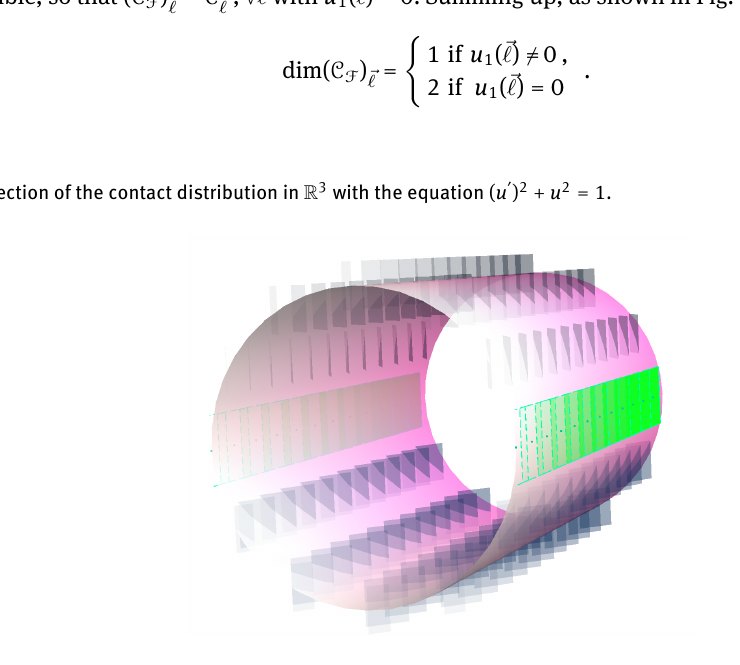
IntersectionoftheContactdistributionwiththeequation ( u ′ ( x )) 2 +( u ( x )) 2 =1 .